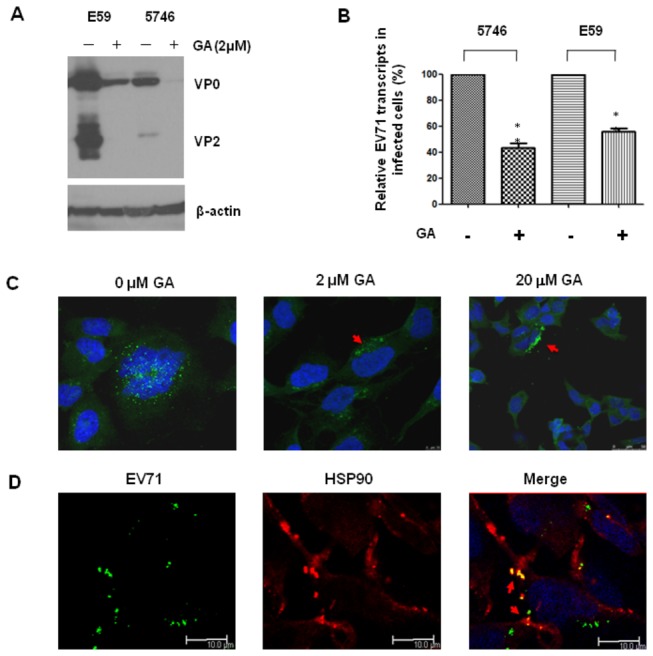
Inhibition of EV71 entry by pretreatment with HSP90 inhibitor.Pretreatment of RD cells with 2 µM or 0 µM (0.1% DMSO) of GA for one hour before MOI = 0.01 of EV71 5746 (C2) and E59 (B4) infection was conducted individually. After one hour infection, (A) cells were washed with Opti-MEM medium and incubated for 16 hours. Cells lysate were further prepared to detect EV71 capsid protein by western blot using MAB979 antibody. The internal cellular β-actin was detected by blotting the same membrane with monoclonal anti-β-actin antibody. (B) RNA was extracted at 90 min post infection and subjected to quantify EV71 transcripts by real-time RT-PCR using the primers against VP1 region. The relative expression of target gene was calculated as described in the Materials and Methods. Each normalized 2Ct value from GA-treated cells was ratio to the value from the mean of 2Ct obtained from the vehicle-treated cells. A schematic representation of the EV71 transcripts expression was shown. Data represented one of two independent experiments. Unpaired student t test with Welch correction was used for statistical analysis. (C) RD cells were treated with various concentration of GA or 0 µm of GA at 37°C for one hour before EV71 (MOI=20) infection for another one hour. After infection, cells were fixed before antibody staining. EV71 was stained with Mab979 antibody. (D) RD cells infected with EV71 (MOI=20) at 4°C for one hour without GA treatment were fixed and stained with Mab979 and anti-HSP90 antibodies (N-17). The respective secondary antibodies conjugated with fluorescence dye described in the Materials and Methods were used. Detection of EV71 (green), HSP90 (red), EV71-HSP90 merging (yellow) and nuclei stained with DAPI (blue) using a confocal microscope Leica TCS SP5 II was performed. The pictures were taken at 200x magnification from 2 independent experiments and one of them was shown.